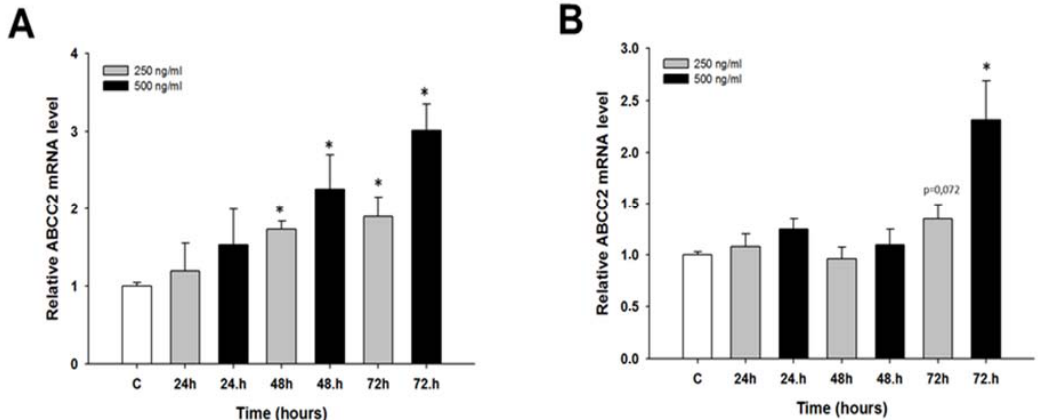
Figure 5. Expression analysis of the ABCC2 gene in: W1 ( A ); and A2780 ( B ) ovarian cancer cell lines. The figure presents the relative gene expression in CIS-treated cells (grey and black bars) with respect to the untreated control (white bars), assigned as 1. The values were considered significant at * p < 0.05. We did not observe any changes in MCTP1 mRNA levels after CIS treatment (not